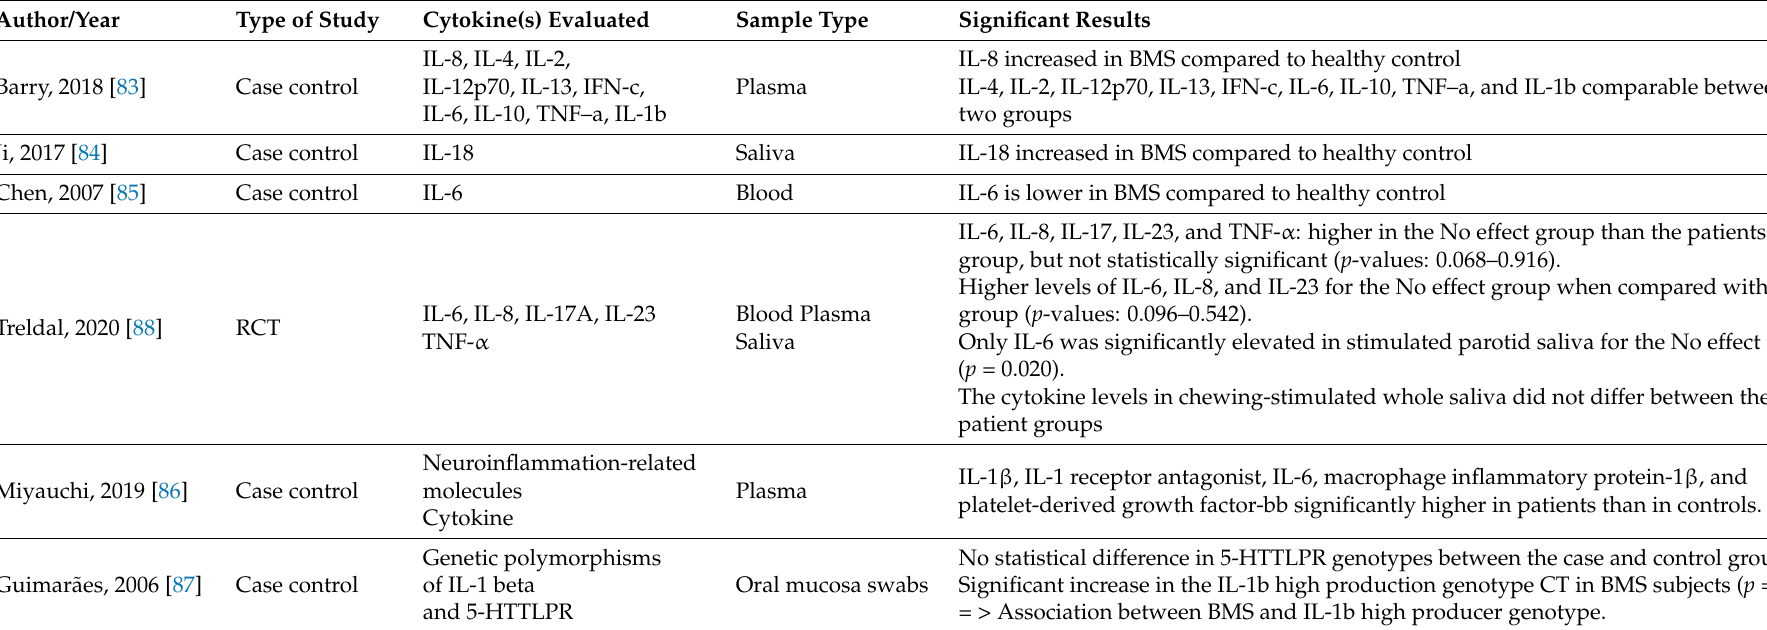
Table 1. Cytokine evaluation of the study